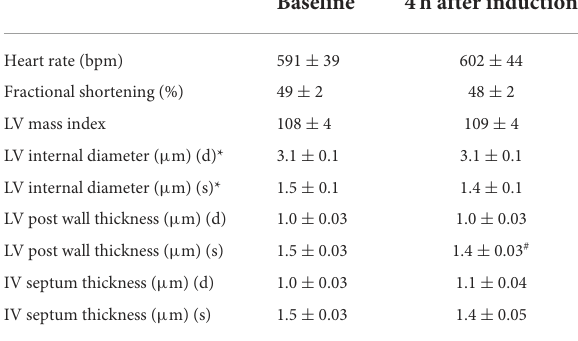
TABLE 2 Baseline echocardiographic parameters for CM-caFGFR1 mice.